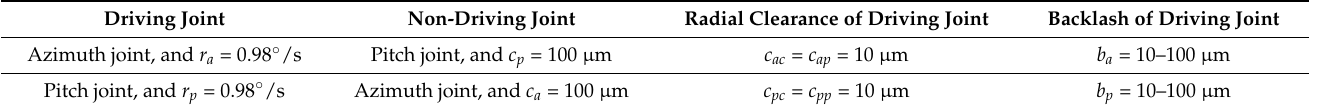
Table 6. Simulation parameters of backlash.